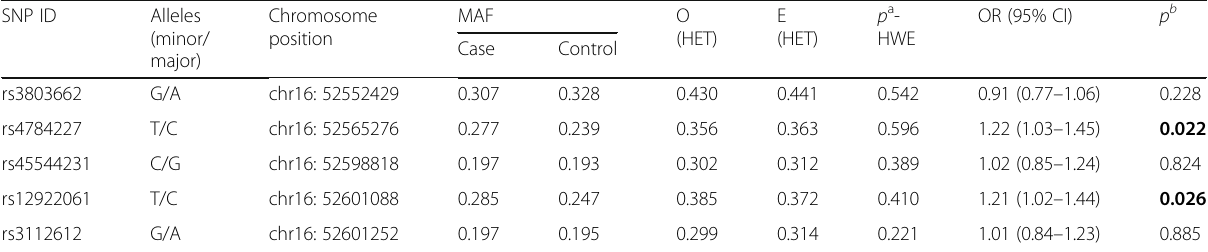
Table 2 The distribution of allele frequencies of CASC16 SNPs in case and